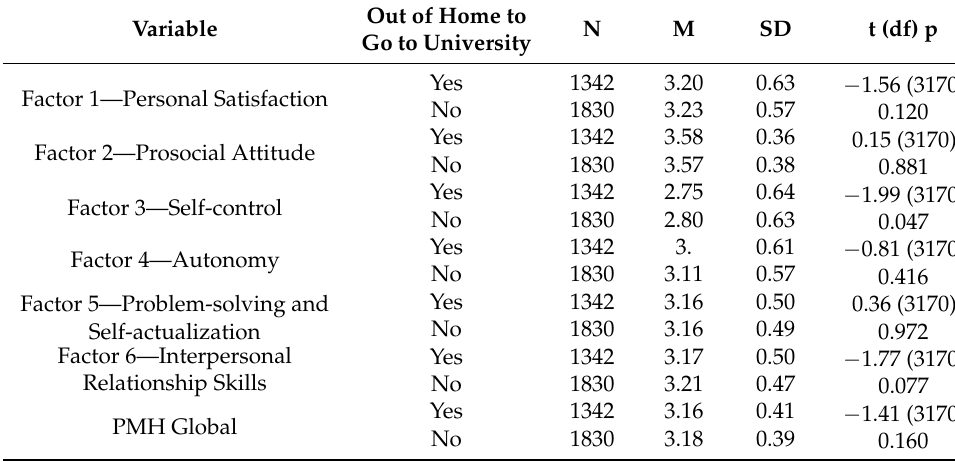
Table 9. Students’ t-test for home and